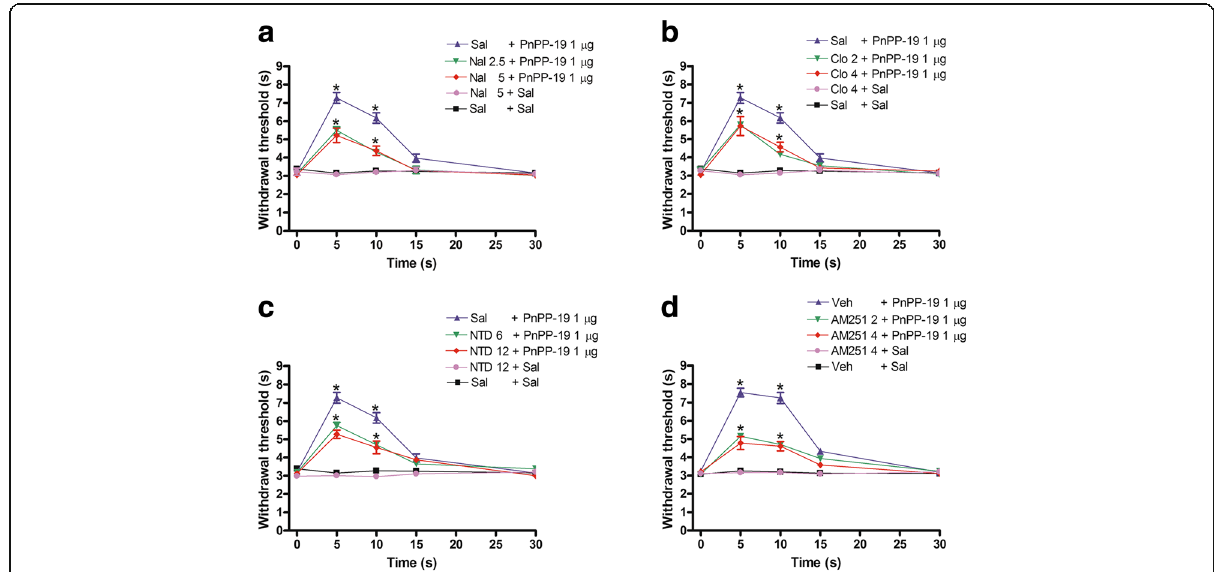
Fig. 2 Partial antagonism induced by intracerebroventricular administration of a naloxone, b clocinnamox, c naltrindole or d AM251 in the central antinociception induced by PnPP-19. Naloxone (Nal; 2.5 and 5 μ g), clocinnamox (Clo; 2 and 4 μ g), naltrindole (NTD; 6 and 12 μ g) or AM251 (2 and 4 μ g) was administered 1 min prior to PnPP-19 injection (1 μ g). These antagonists did not significantly modify the nociceptive threshold in the control group. Each line represents the mean ± SEM for four mice per group. *Significant difference compared to the control group (ANOVA + Bonferroni ’ s test). Sal: saline (0.5% of Evans Blue); Veh: vehicle (20% DMSO in saline 0.5% of Evans